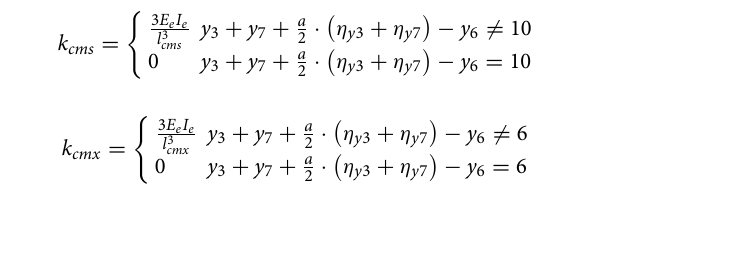
Substituting Eqs. (1)–(3) into the Lagrange kinetic equations, the integral equation is processed into the form of Eq. (4) to obtain the matrices M, C, K and F (see “ESM Appendix”). Establishment of the stiffness model for key components. Connection stiffness model of the shearer body with traction part. According to the structure of the shearer, the stiffness models of the four hydraulic tie bars can be used to describe the connection state between the shearer body and the traction part. The relevant parameters of the hydraulic tie bars are shown in Table 2. The equivalent connection stiffness of the traction part with shearer body are: